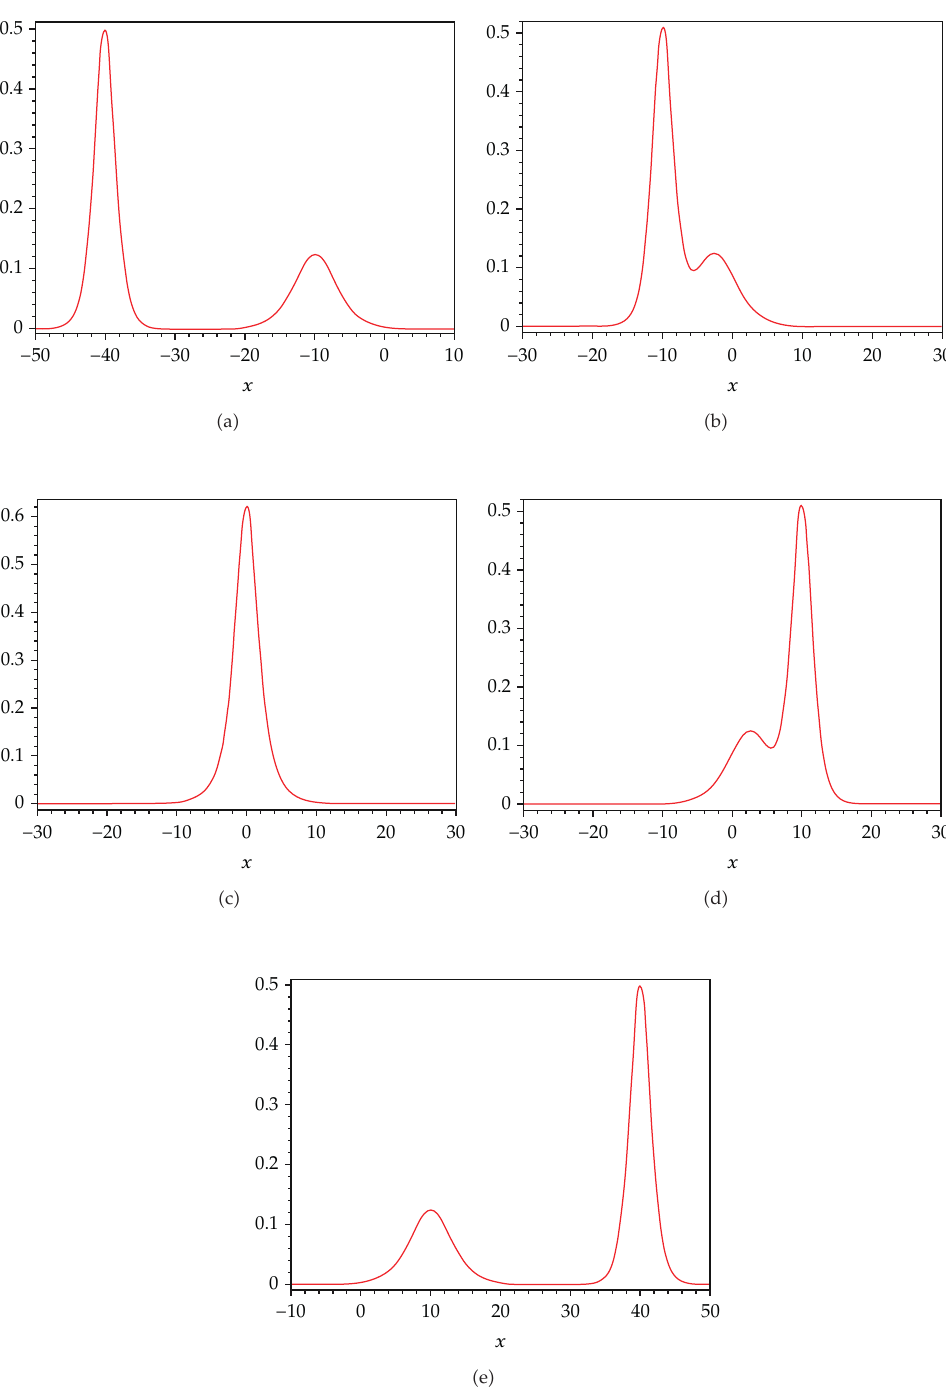
Figure 2: Collision of two solitary